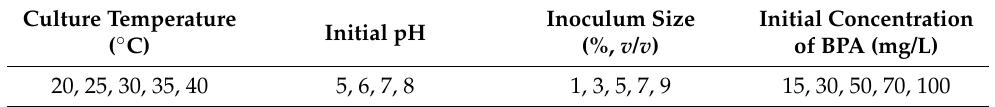
Table 1. Conditions of single-factor